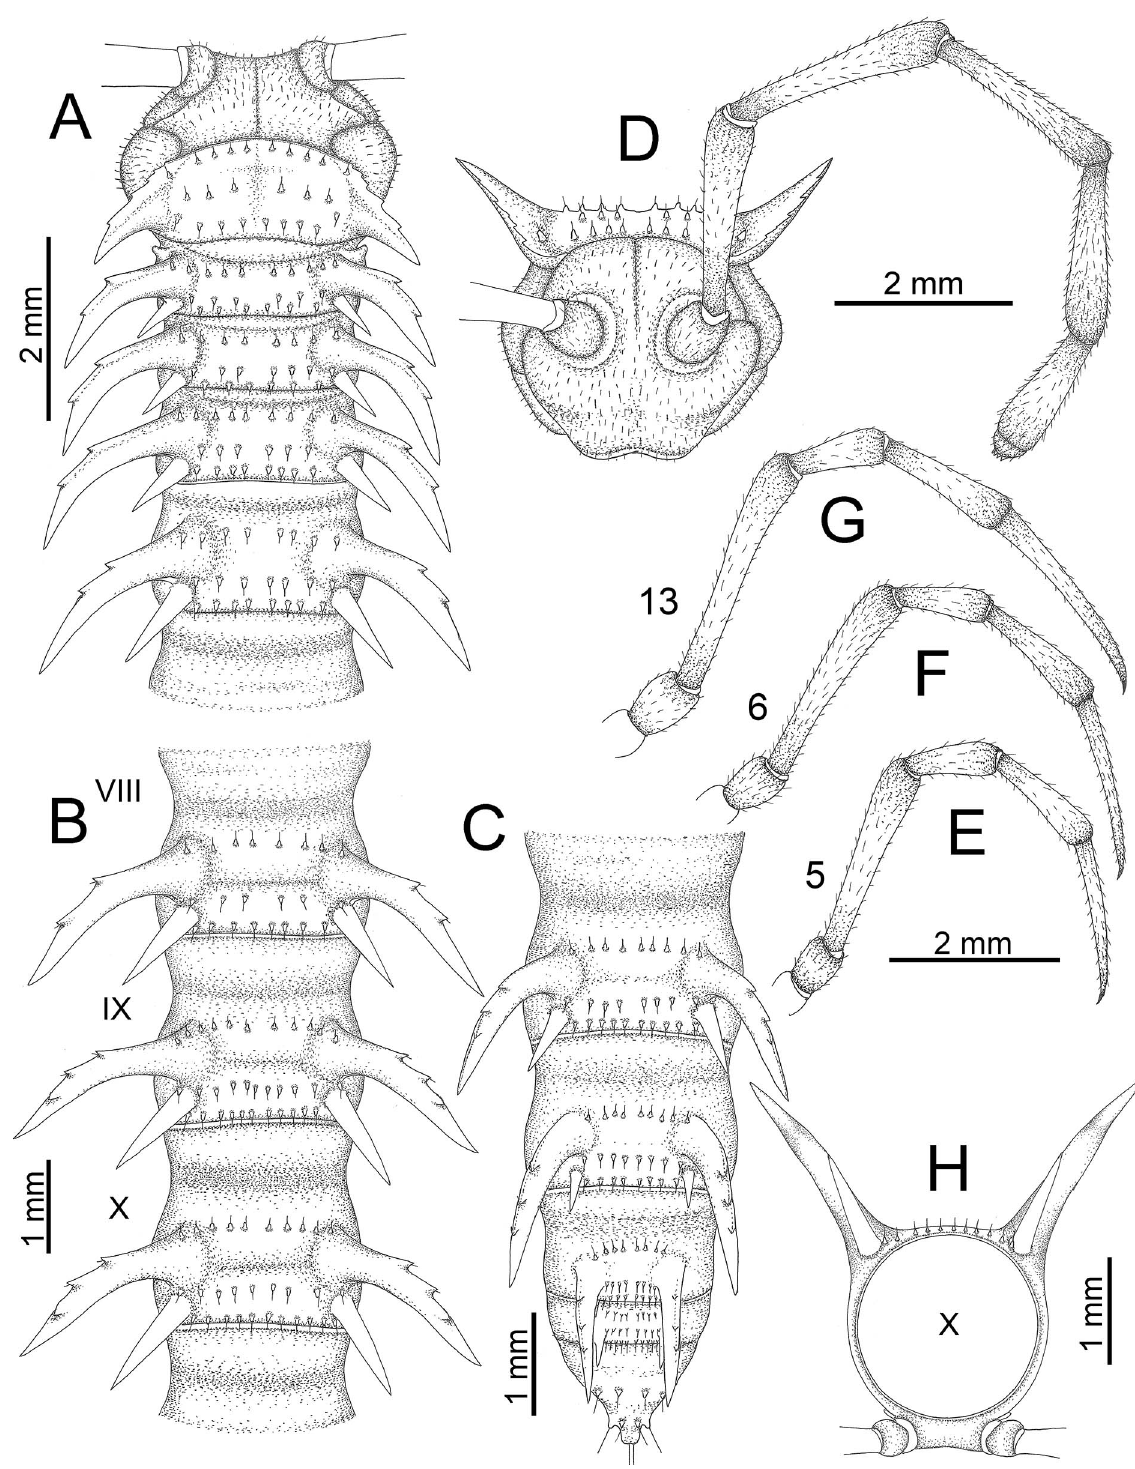
Fig. 10. Gigaxytes gigas (Golovatch & Enghoff, 1994) gen. et comb. nov., ♂, specimen from Wat Tham Sue (Tiger Cave). A . Anterior body part. B . Body rings 8–10. C . Posteriormost body rings and telson. D . Head and antenna. E . ♂ leg 5 (right). F . ♂ leg 6 (right). G . ♂ leg 13 (right). H . Midbody